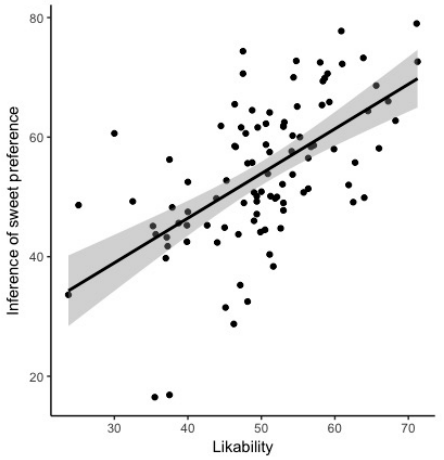
Figure A2. Scatterplot of the relationship between perceived happiness and inferences of sweet preference.